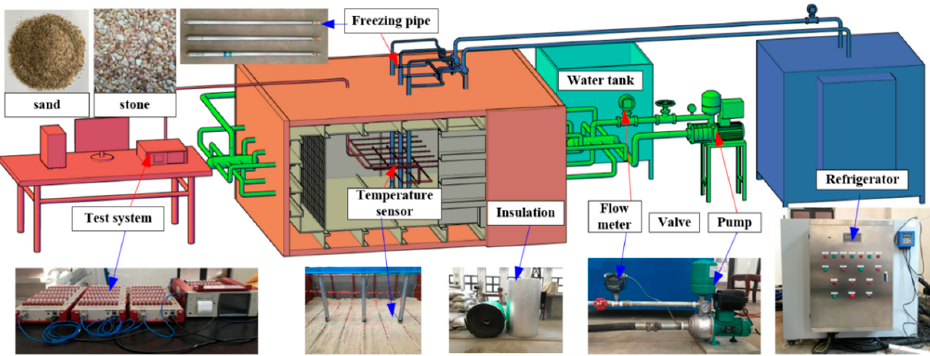
Figure 1. Test system diagram.